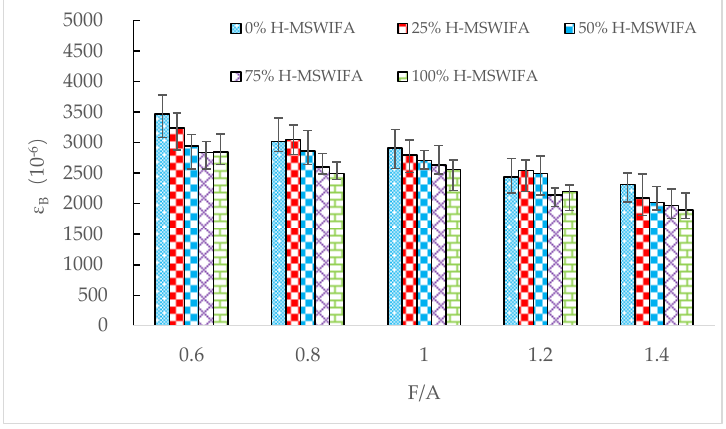
Figure 16. The ε B of AC-13.